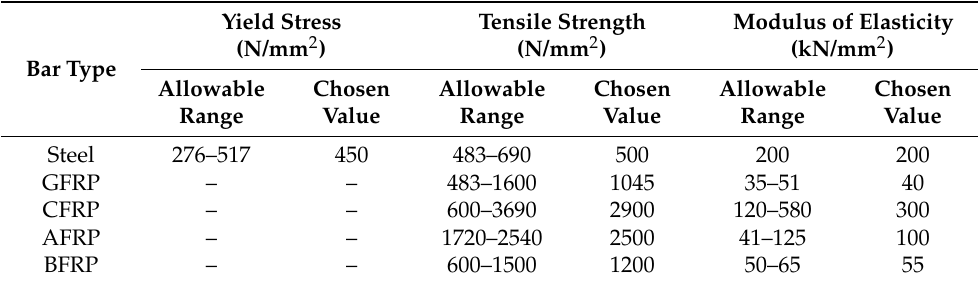
Table 2. Steel and FRP properties.